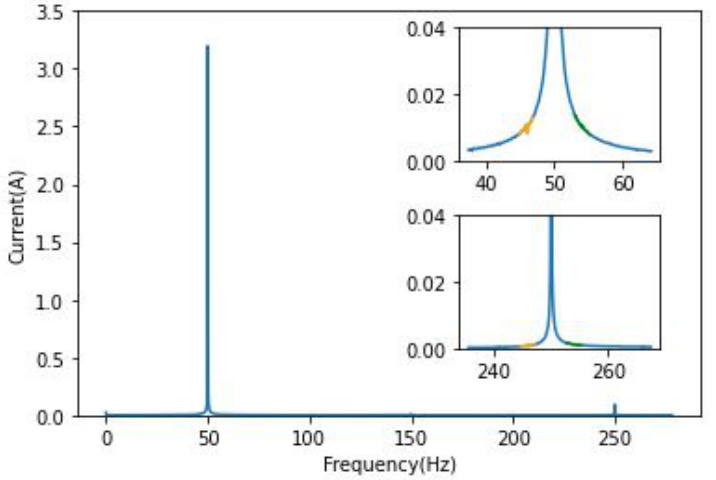
Figure 2. FFT phase current of healthy IM/Zoom around 50 and 250